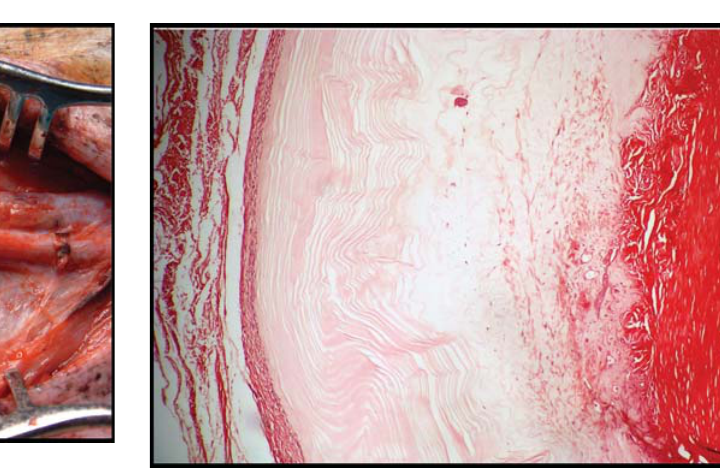
FIGURE 3 - Chronic inflammatory reaction in the outer surface and fibrosis in the inner surface of the sugarcane membrane